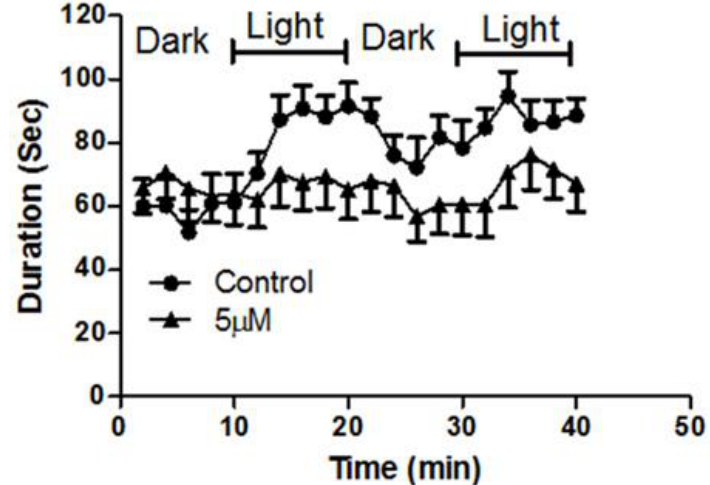
Figure 9. MH altered larvae’ locomotor responses to light and dark stimuli. Medaka larvae (2 days post hatching (dph)) were monitored for 40 min (0–10 min dark, 10–20 min light, 20–30 min dark, 30–40 min light) using a ViewPoint Zebrabox. Duration of movements was measured at 2 min intervals t -test, p < 0.05) increase in activity in MH-treated larvae (solid closed triangles, n = 14) was noted